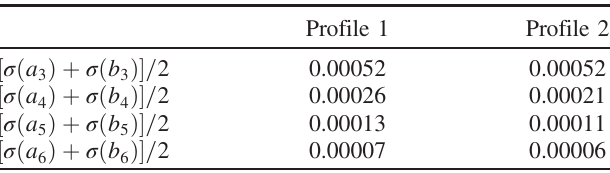
TABLE VI. Random multipoles computed for tol ¼ 0 . 040 mm and expressed at 7 mm, for the two profiles plotted in Fig. 9.